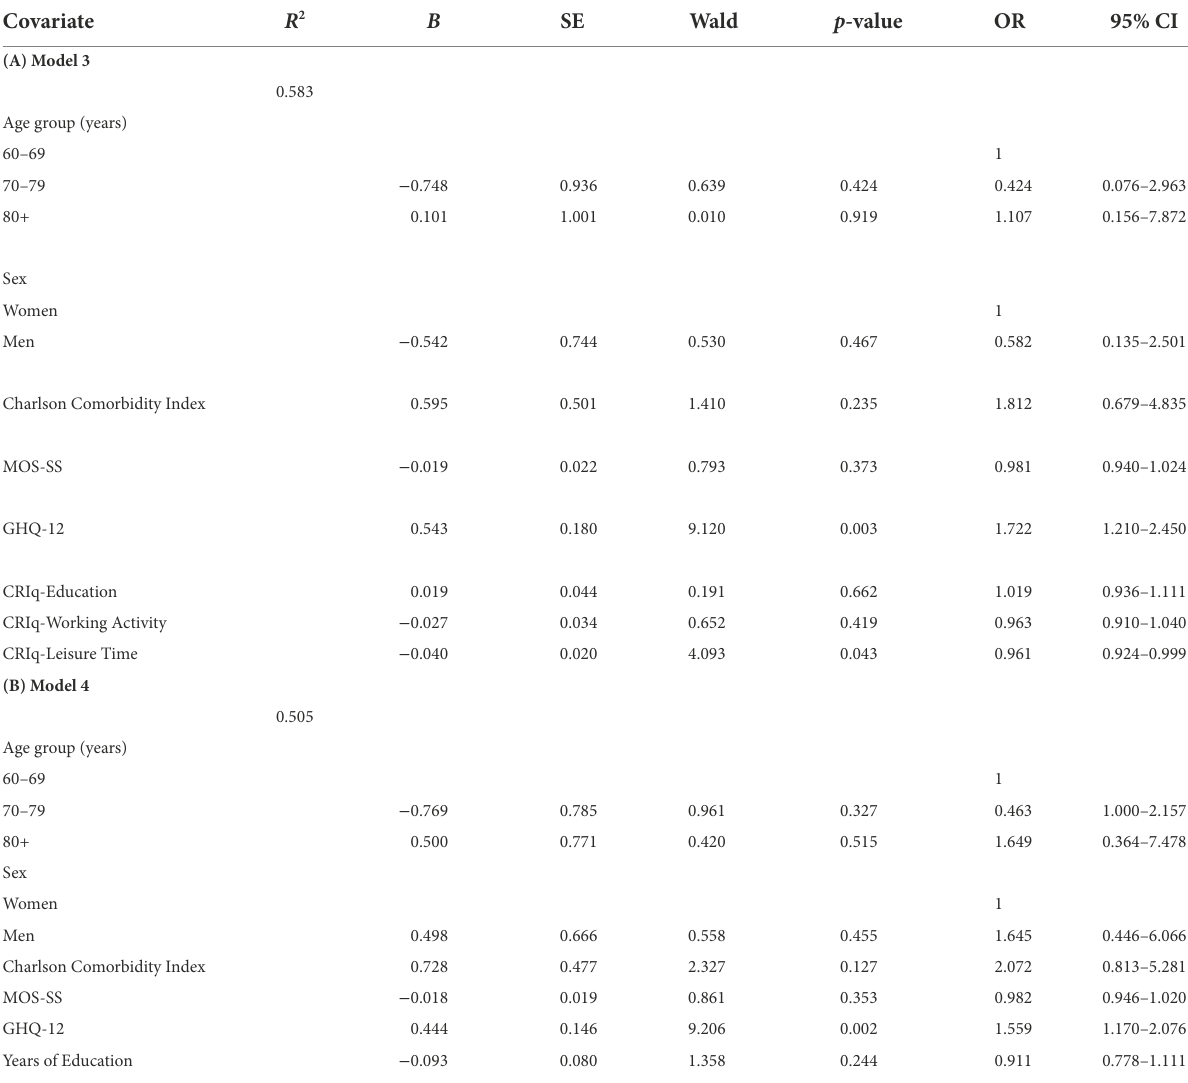
TABLE 4 Multivariate regression